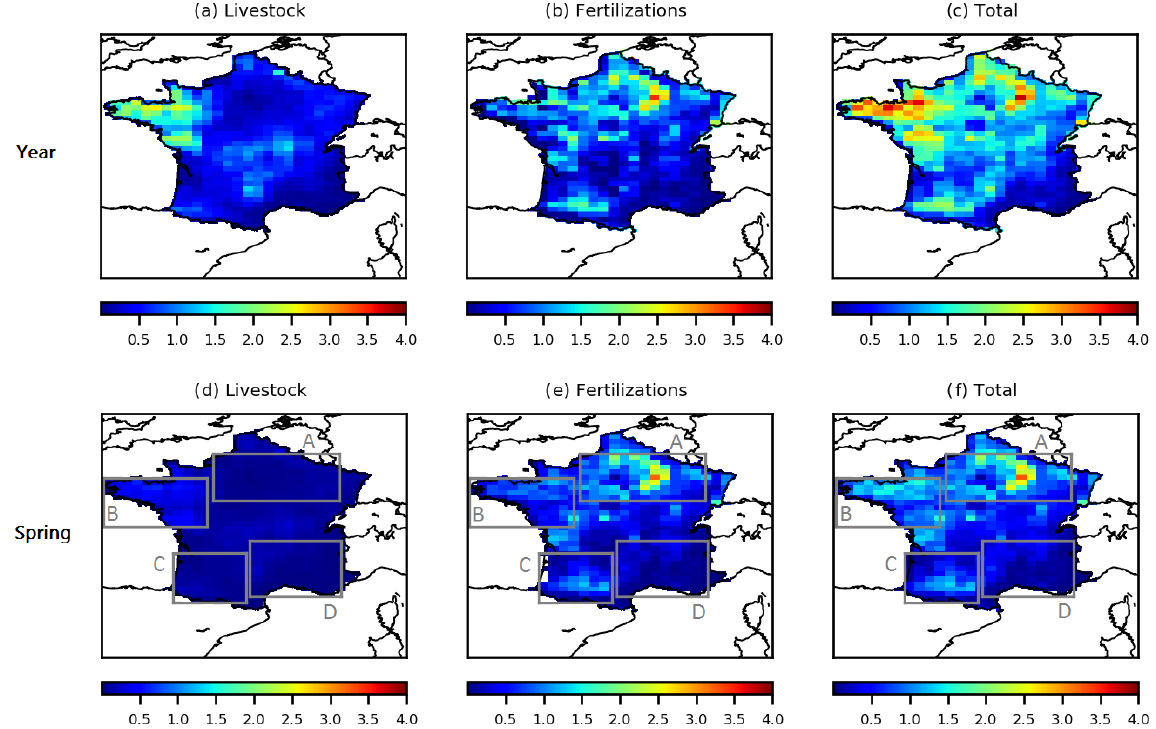
Figure 3. (a–c) Yearly NH 3 emissions due to (a) livestock husbandry and manure storage, (b) N fertilization (organic and mineral), and (c) all sources in the CADASTRE-CIT inventory, in kilotons of NH 3 (ktNH 3 ). (d–f) The same for spring NH 3 emissions, from March to May